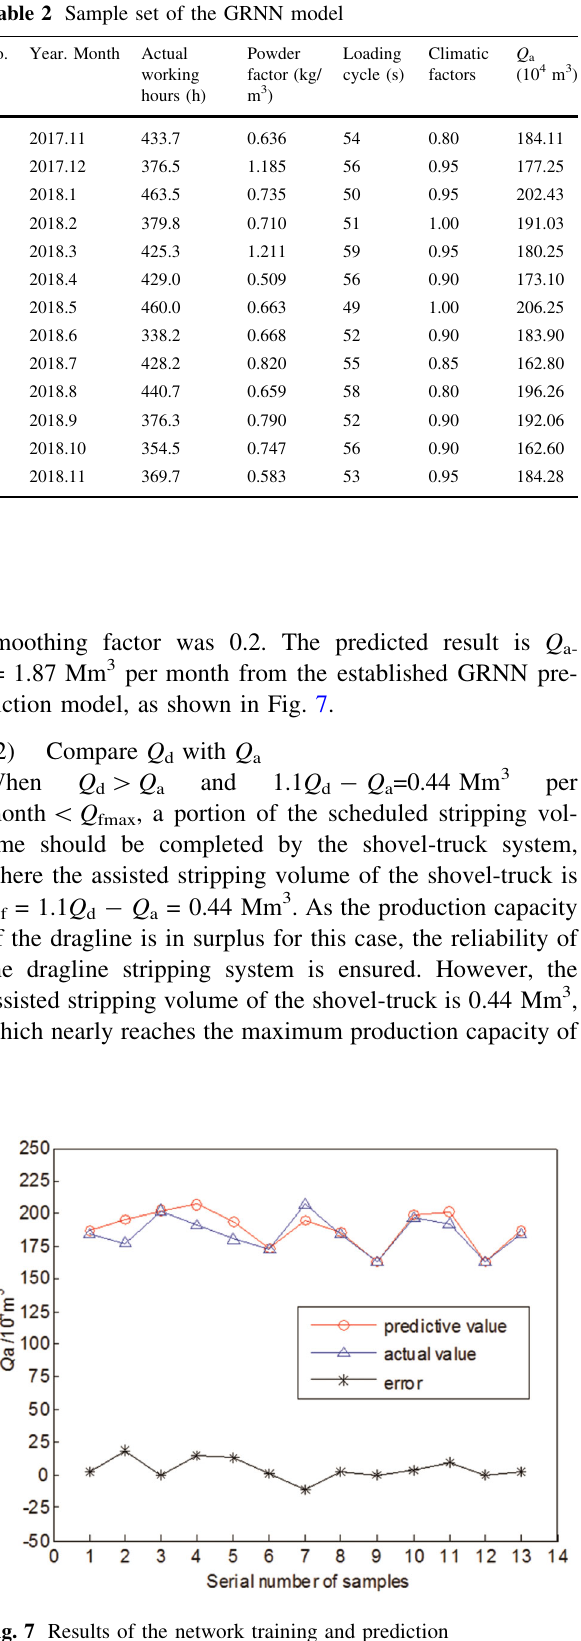
Fig. 7 Results of the network training and